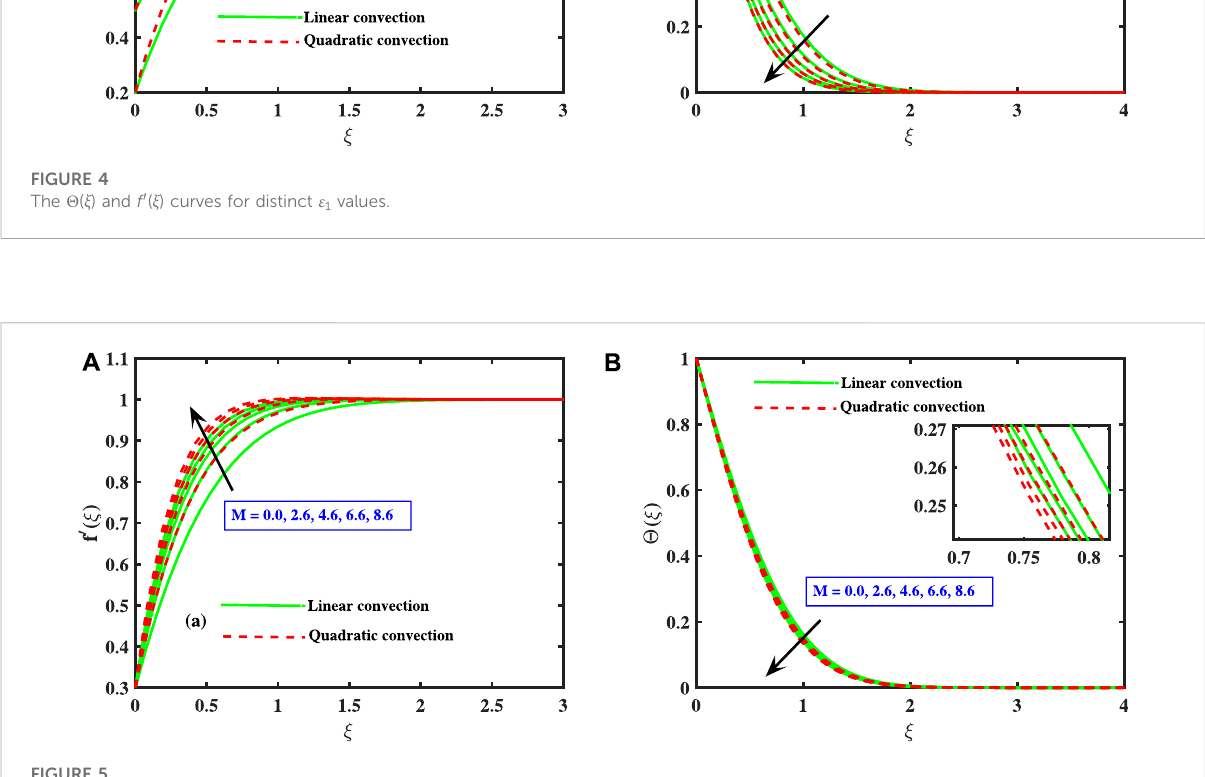
FIGURE 5 The Θ ( ξ ) and f ′ ( ξ ) curves for distinct M